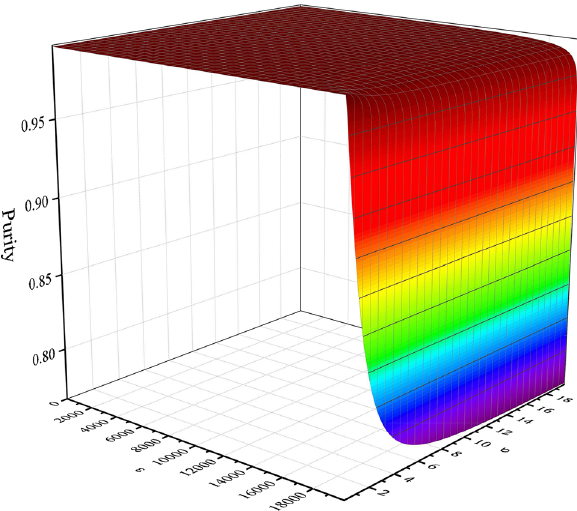
Fig. 3 The purity Tr (ρ 2 ) of the final state of the qubit as a function of the volume ε and the rapidity σ of the cosmic expansion. The qubit energy level difference is (cid:15) = 2, the inner product of the mode func- tions, defined in Eq. (21), is μ = 0 . 1, the mass of the scalarfield particle ( | 0 (cid:7) + | 1 (cid:7) is m = 0 . 01. The initial state of the qubit is 1 √ 2